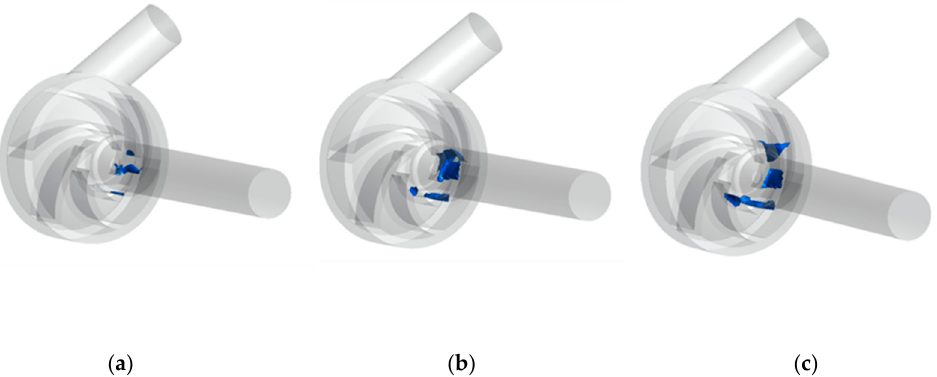
Figure 10. Cavitation bubbles in pump impellers at different inlet pressures: ( a ) Pin = 11 kPa; ( b ) Pin = 10 kPa; ( c ) Pin = 9 kPa.